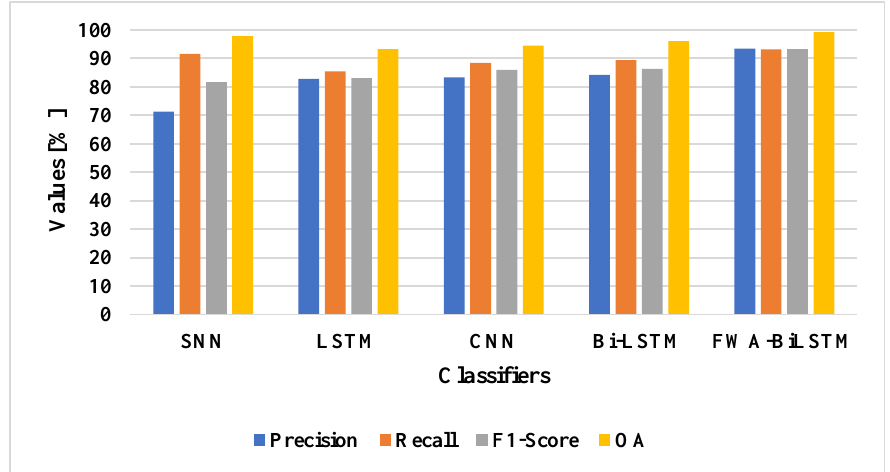
13 of 21 Figure 6. Classifier comparison of FWA-BiLSTM model on LEVIR-CD dataset. The FWA-BiLSTM model had an attention layer that provided higher feature weight values to relevant features which helped the BiLSTM model to increase the efficiency of the classification. The SNN [41] obtained better performance in an imbalanced dataset, while the LSTM and BiLSTM models had vanishing gradient problems, and the CNN model encountered an overfitting problem. When compared with existing methods, the proposed FWA-BiLSTM model achieved a higher recall value. Due to this fact, the model selected unique features in order to distinguish the changes. The FWA-BiLSTM model obtained 93.43% precision, 93.16% recall, and 99.26% OA, whereas the BiLSTM model had 86.91% precision, 84.80% recall, and 88.18 %OA. The FWA-BiLSTM was compared with attention layer classifiers on the LEVIR-CD dataset, as shown in Table 3 and Figure 7. Table 3. Performance of classifier with attention layer on LEVIR-CD dataset.